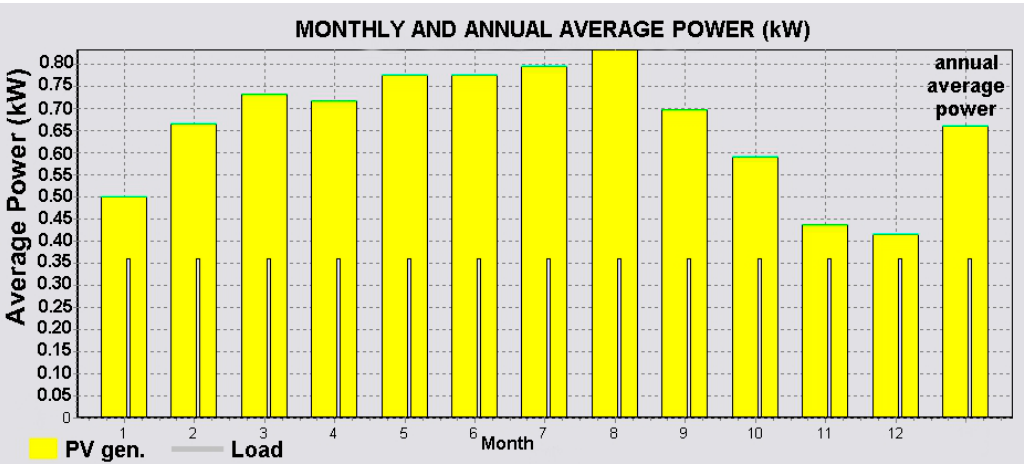
Figure 6. Monthly and annual average power.